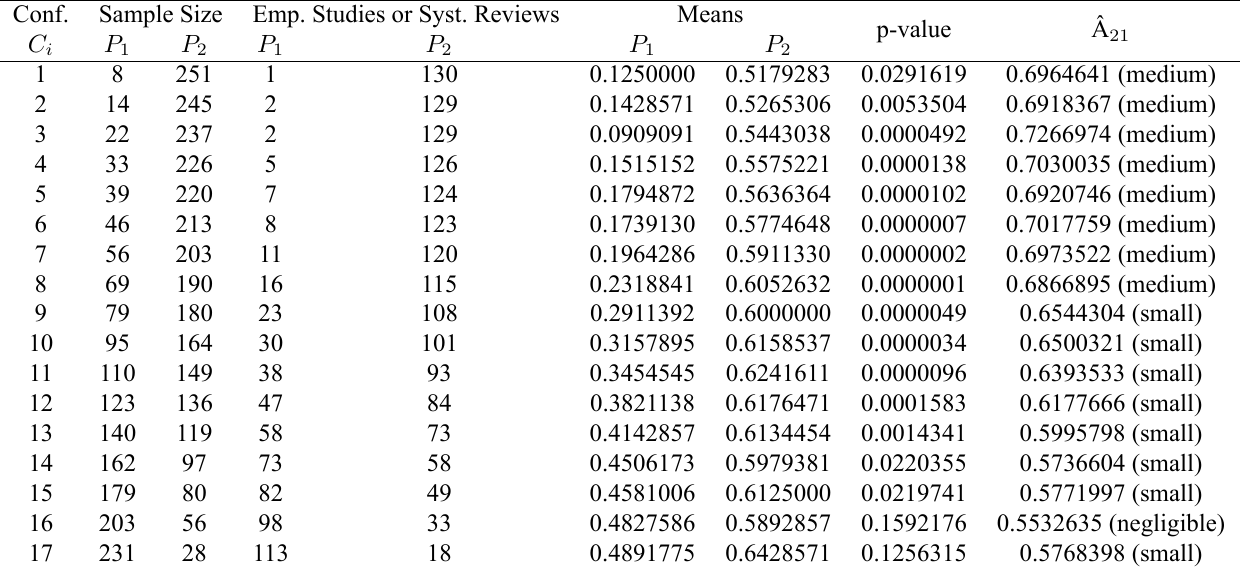
Figure 8. Quantity of empirical studies and systematic reviews performed by year Table 3. Distribution of studies with empirical evaluation or a systematic review.